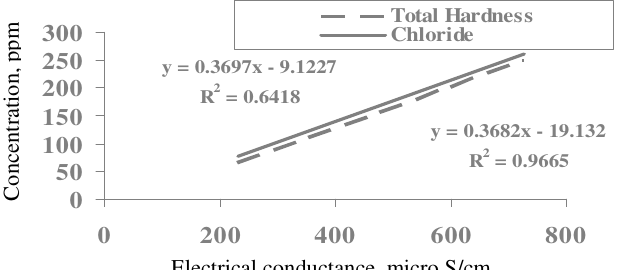
Figure 3 . Correlation of EC with TH and Chloride.